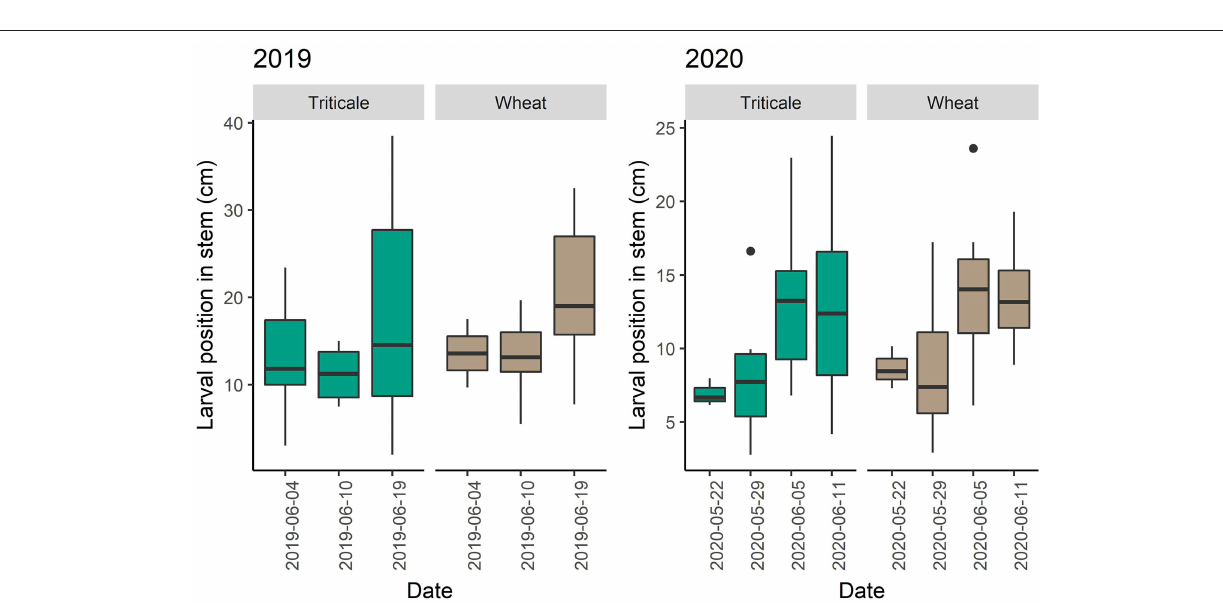
2019). While triticale is a suitable host for the wheat stem